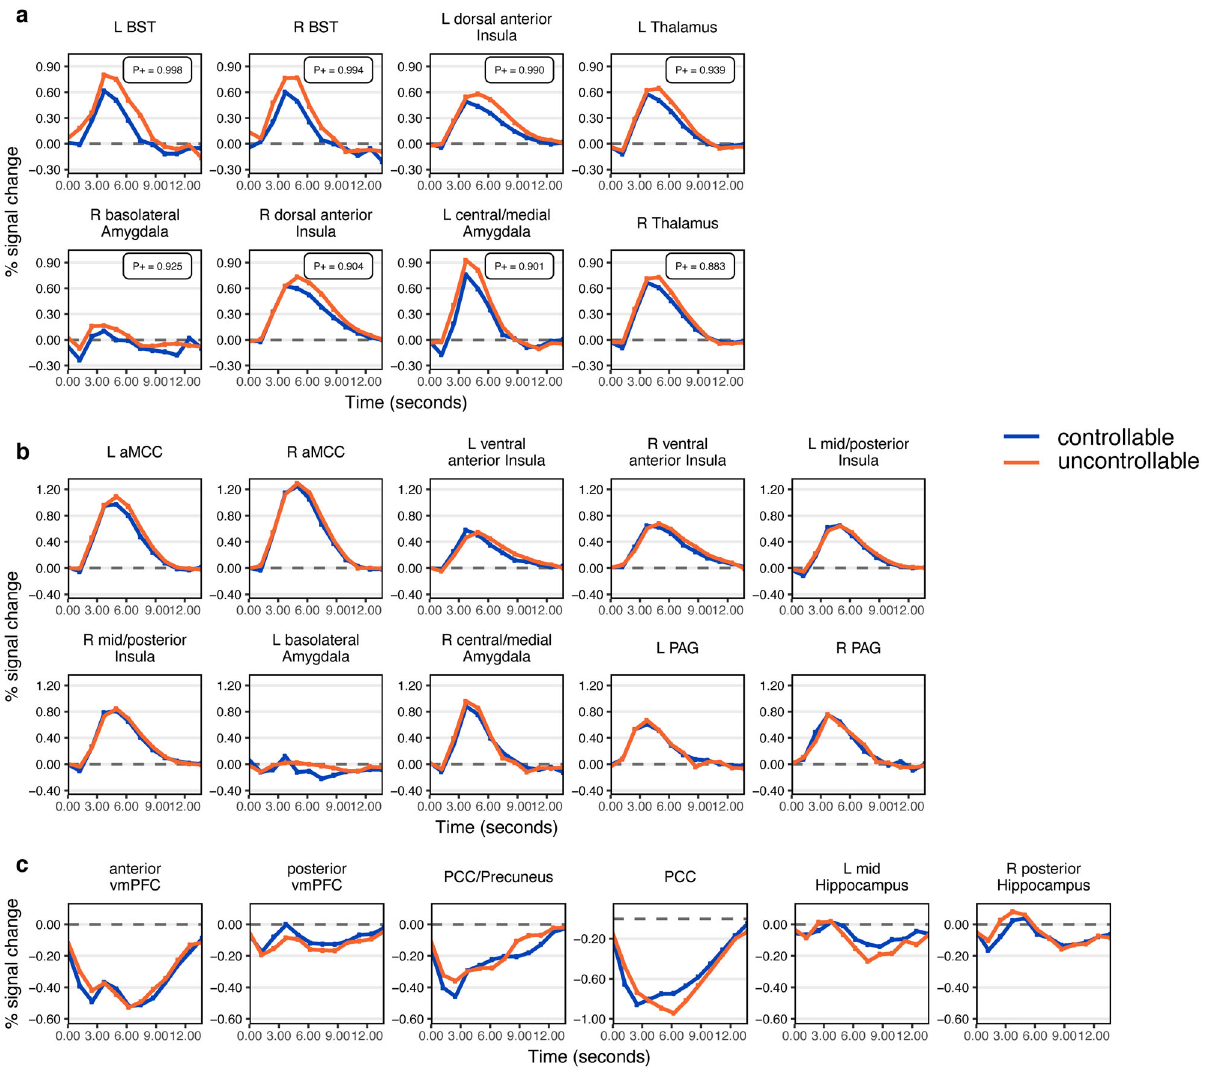
Fig. 4 Stressor-related responses at regions of interest. Unassumed shape analysis was used to estimate evoked responses to stressors for all ROIs. a ROIs with stronger evidence of a controllability effect. P + values ( P (effect > 0)) shown. b – c Responses for the remaining ROIs, with the responses to the stressor that were positive-going in b and those that were negative-going in c . Mid and posterior Hippocampus ROIs are also shown in c